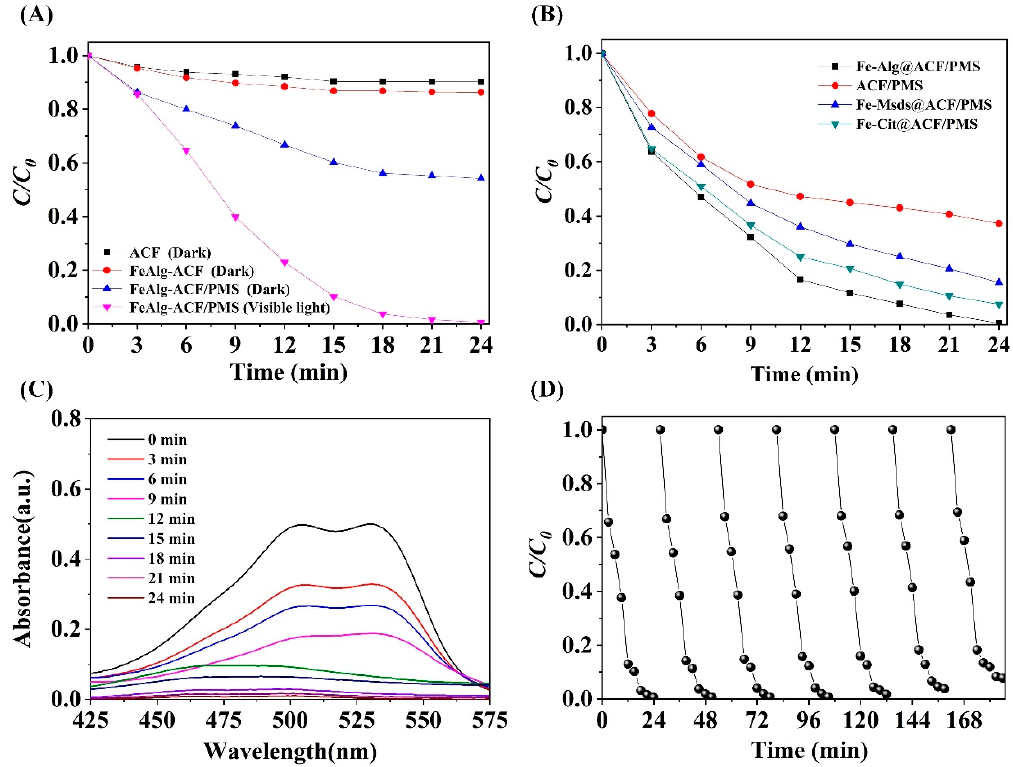
Figure 2. ( A ) Time-dependent profiles of azophloxine decolorization with and without light irradiation; ( B ) Decolorization of azophloxine by different systems as a function of time; ( C ) UV–vis spectra of azophloxine solutions after removal by the FeAlg-ACF/peroxymonosulfate (PMS) system; ( D ) Azophloxine removal by FeAlg-ACF/PMS after a certain number of cycles. Reaction conditions: [FeAlg-ACF] = 2 g/L, [PMS] = 5 mmol/L, [azophloxine] = 50 μ mol/L, initial pH = 4.0, T = 25 °C. The effects of different systems on azophloxine removal are compared in Figure 2B.